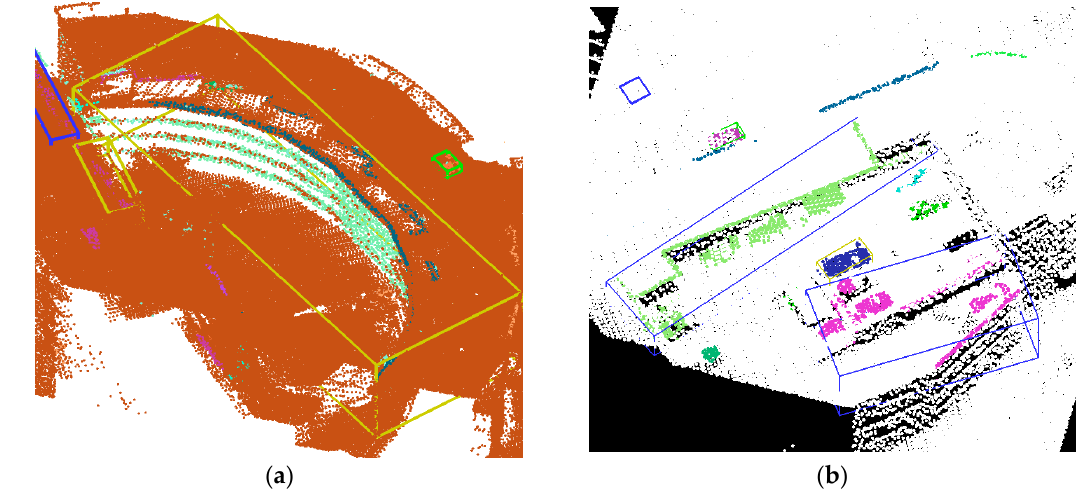
Figure 20. 3D bounding boxes of some wrong changes and irrelevant changes. ( a ) Incorrect changes in walls and irrelevant changes on roofs; ( b ) Cars that are close to each other and close to some fences are grouped to large objects. Yellow cubes are show objects classified as new buildings. Blue cubes are new unknown objects. Green cubes are new constructions on top of the roof.